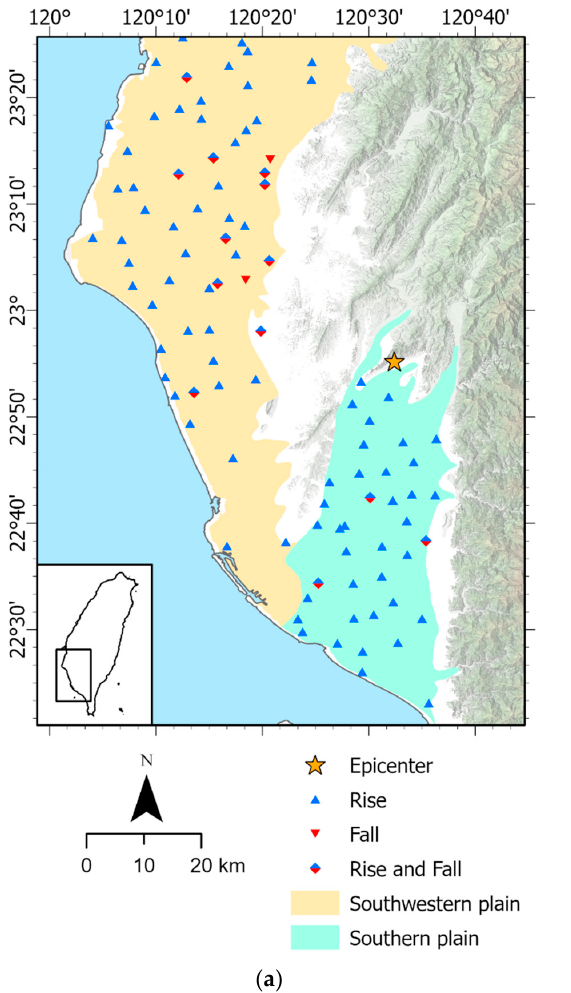
Figure 11. ( a ) Regional distribution of coseismic groundwater level changes in southwestern Taiwan due to the 2016 M6.4 earthquake; ( b ) magnitude of coseismic rises and falls versus hypocentral distance in the southern plain and southwestern plain.